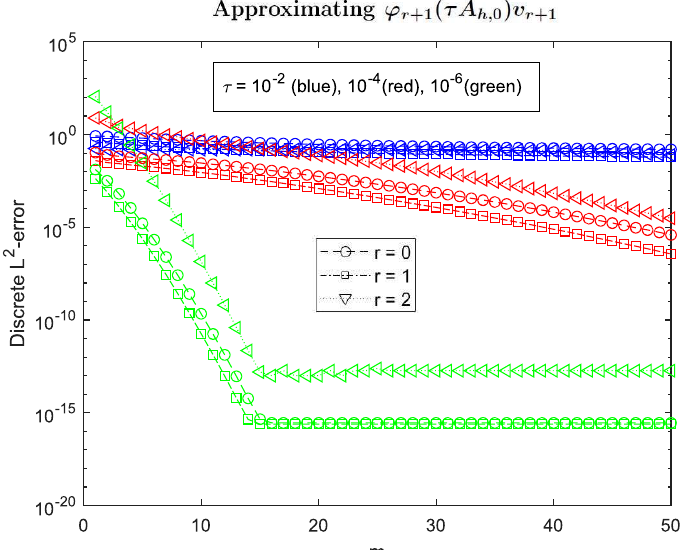
Figure 4. Discrete L 2 -error against number of Krylov iterations when approximating ϕ r + 1 ( τ A h ,0 ) v r + 1 for v r + 1 in (22), different values of τ , r = 0,1,2 and fixed h = 10 − 3 .